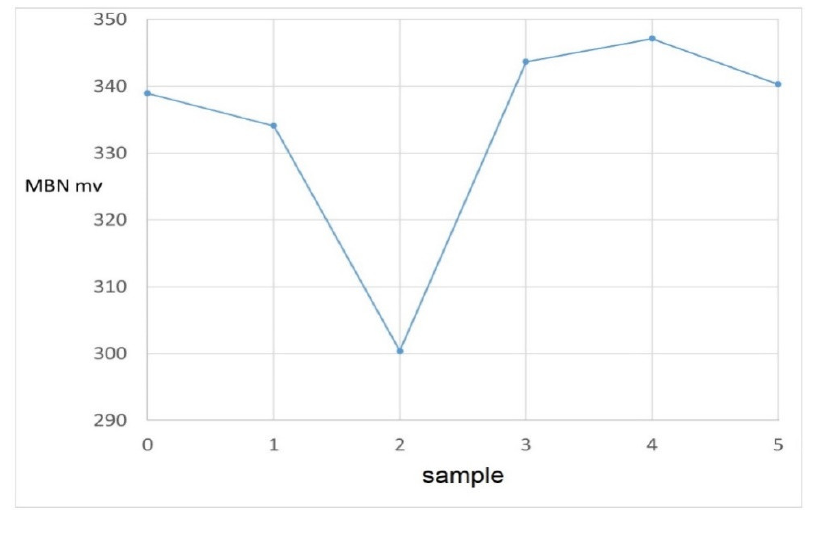
Figure 8. Sample No. 5—Barkhausen noise 340 mV—position of envelope maximum—7.7 a.u.—envelope extension (FWHM) 70.2 a.u.